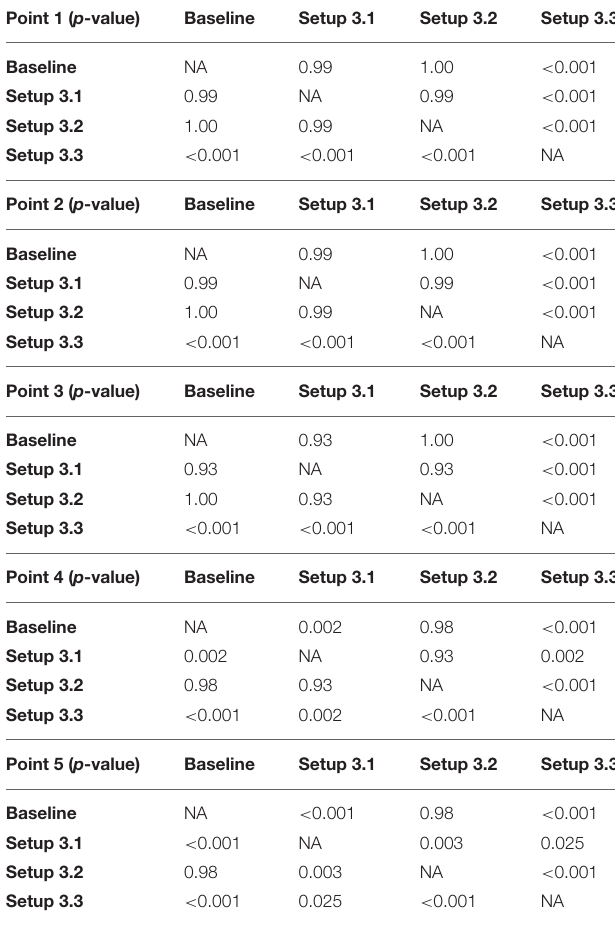
TABLE 3 | Distances measured between the baseline points after each variable, for each setup